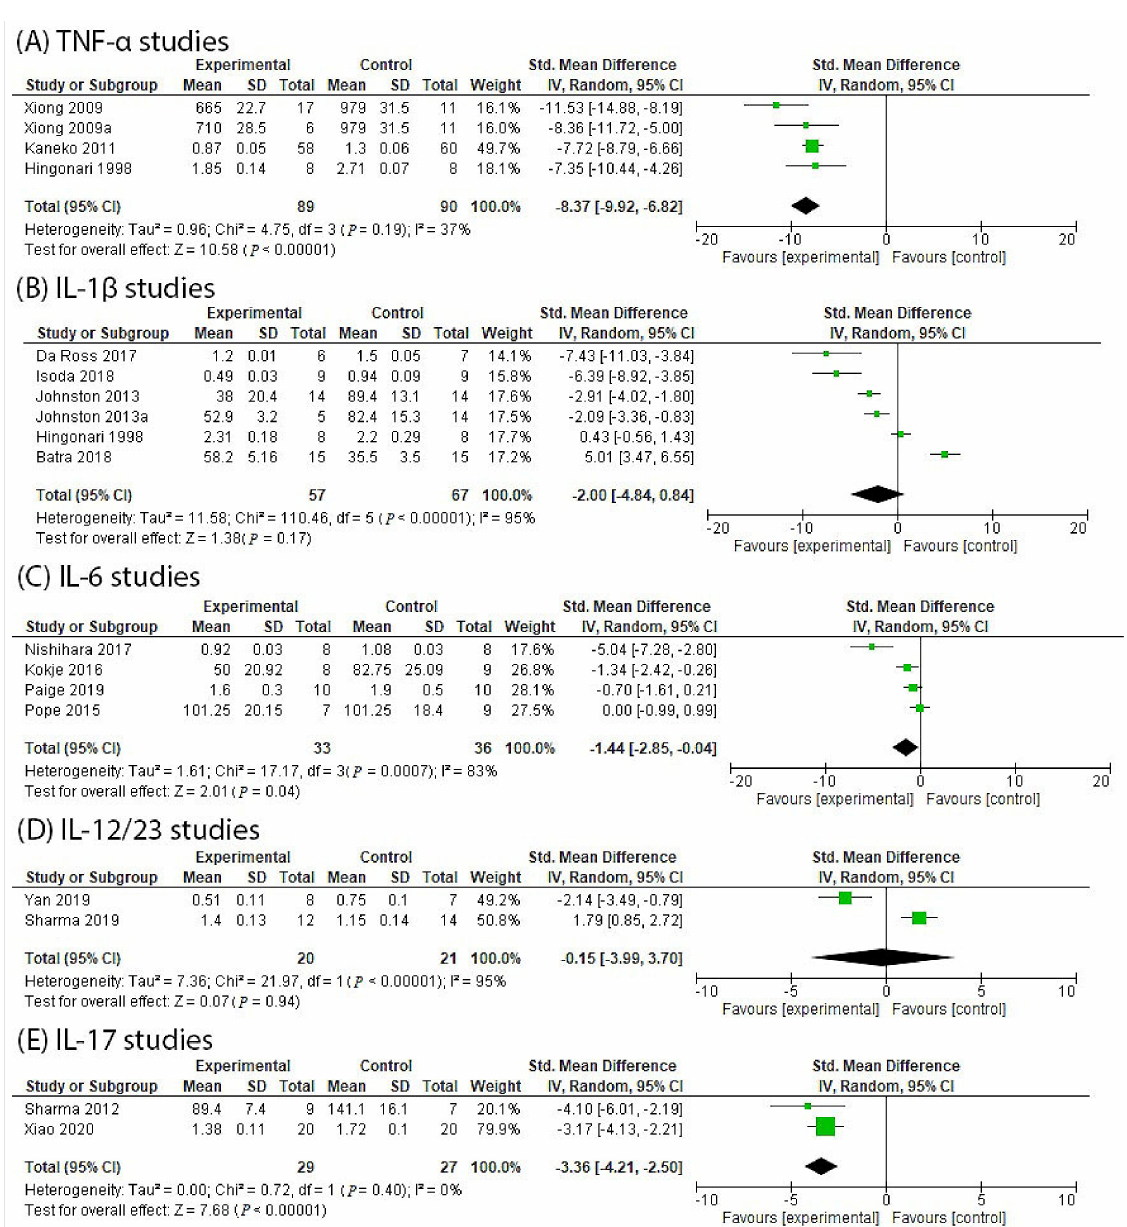
Figure 1. Meta-analysis testing the effect of blocking TNF or IL in rodent models of AAA. ( A ) TNF- α inhibition significantly reduced AAA diameter [28,30,31]; ( B ) IL-1 β inhibition did not significantly reduce AAA diameter [30,32–35]; ( C ) IL-6 inhibition significantly reduced AAA diameter [36–39]; ( D ) IL-12/23 inhibition did not significantly reduce AAA diameter [40,41]; ( E ) IL-17 inhibition significantly reduced AAA diameter [42,43]. Note: Meta-analyses were performed only when a minimum of two relevant studies were identified. TNF, tumour necrosis factor; IL, interleukin; AAA, abdominal aortic